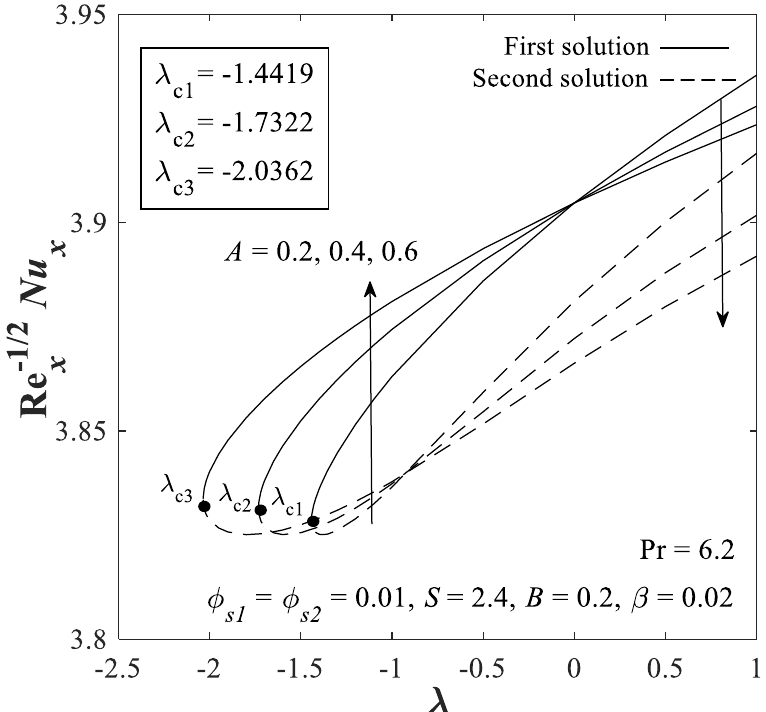
− 1/2 Nu with λ for varied A . Figure 3. Plot of Re x Nu x with λ for varied A . x x